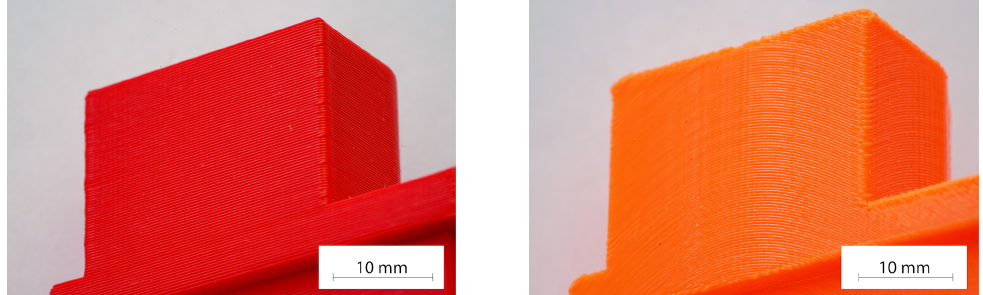
Figure 17. Horizontal layers of the printed reference part printed on a Prusa Mk3s ( red ) and the RotBot ( orange ).